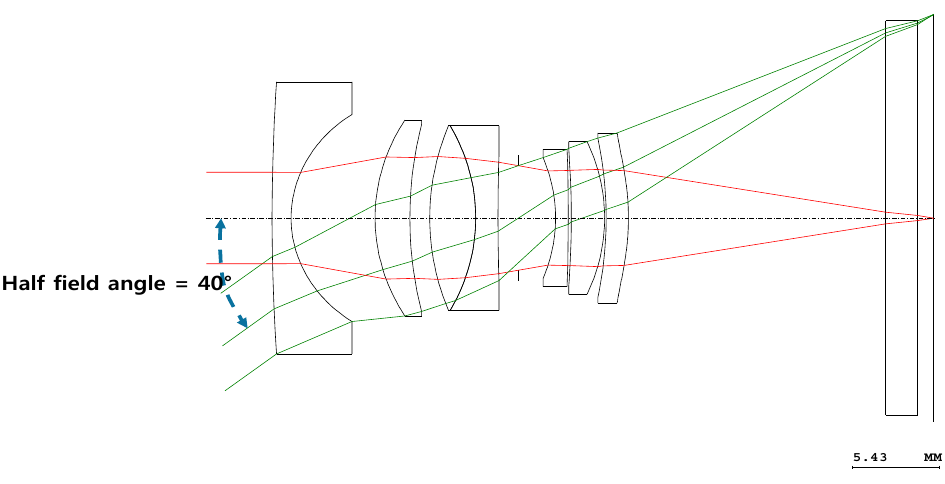
Figure 1. Optical layout of a conventional wide-angle system.